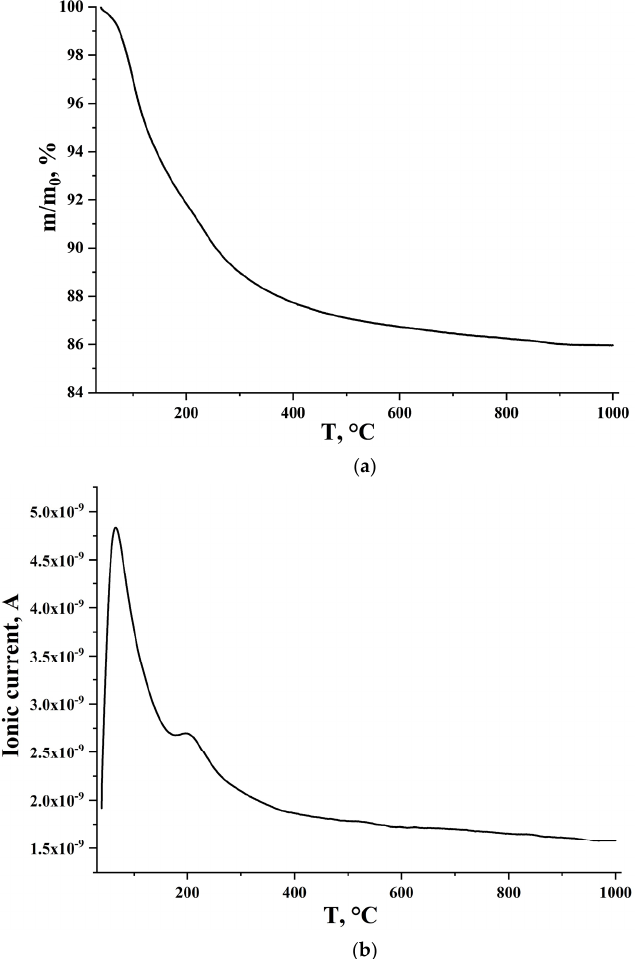
Figure 3. Thermal analysis data ( a ) and Mass spectrum for evolving gas with m/Z (H 2 O) = 18 ( b ) of the sample after drying in the air for 24 h at room temperature based on the hydroxyapatite powder and the aqueous solution of sodium